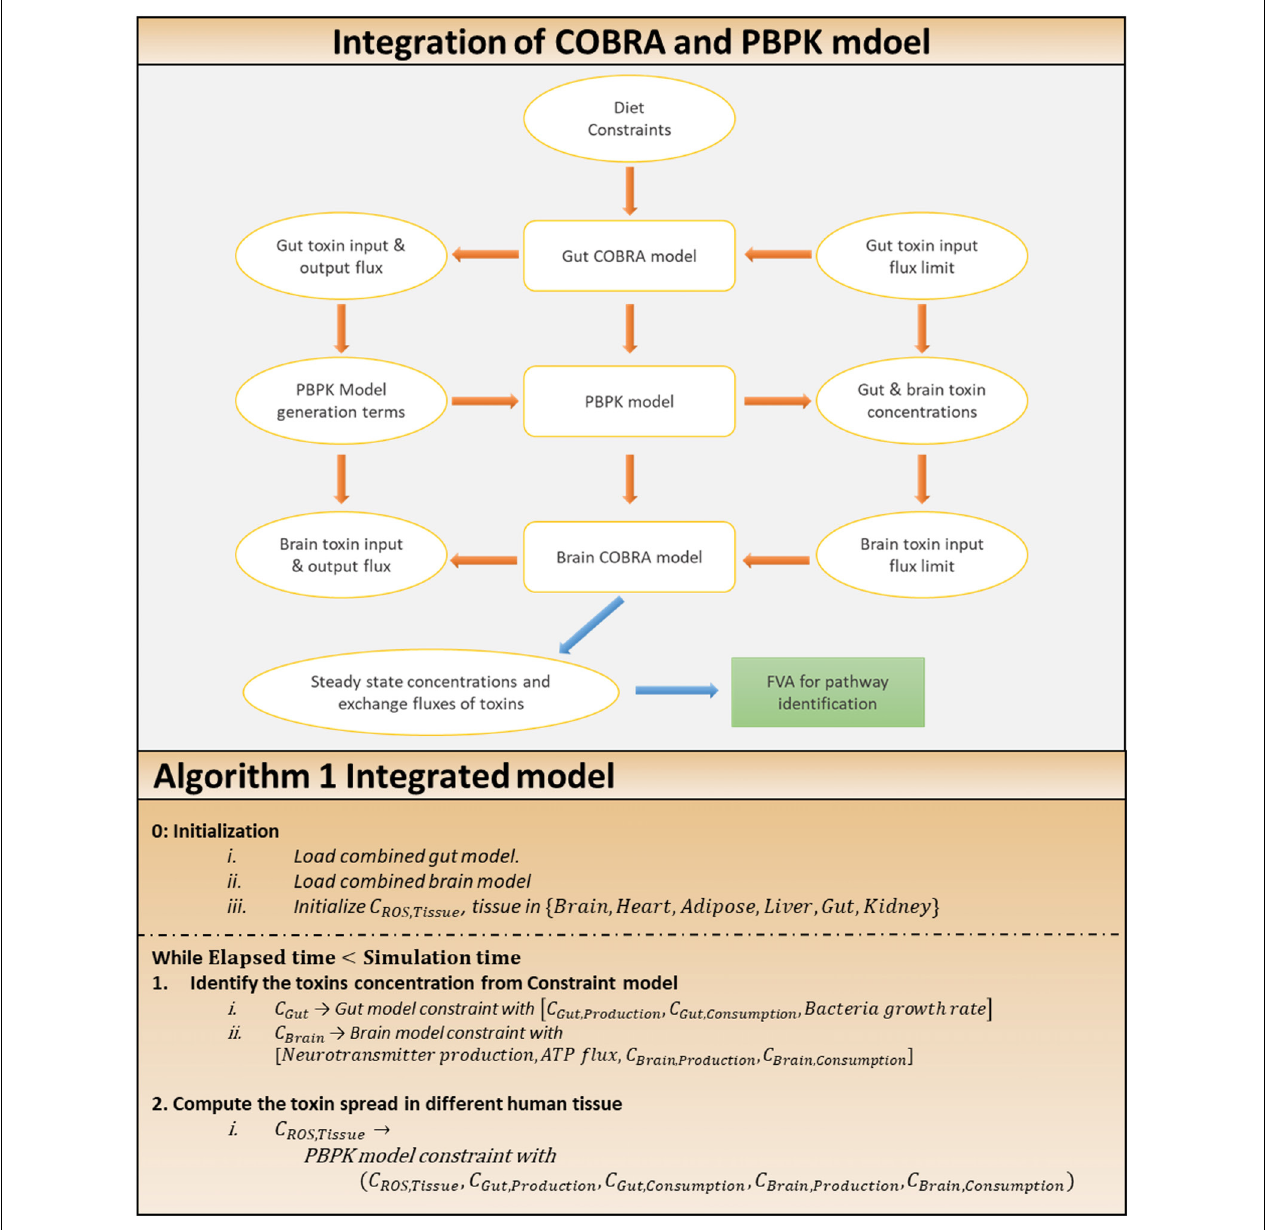
FIGURE 4 | Approach for the integration of COBRA and PBPK model. Integration of COBRA and PBPK model: the integrated model, showing the interactions between the gut, brain COBRA models and the transport PBPK model. Simulation of the integrated model yields the steady state exchange fluxes of toxins used for further analysis through FVA to identify altered pathways. Algorithm 1: algorithm for the integration of two model.